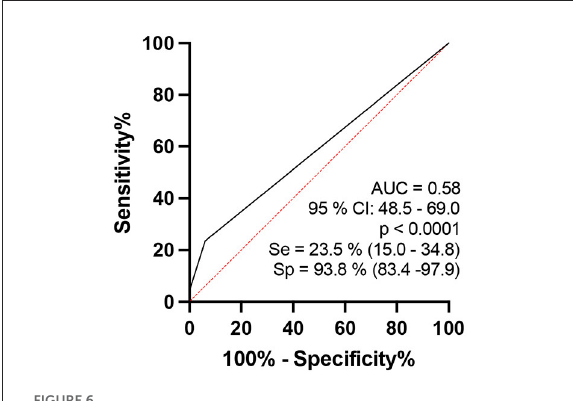
FIGURE6 ROC curve analysis of the percentage indices of the number of focalities ( 1 TpT) of the evaluated neural points considered to be altered per individual when comparing the groups of healthy persons and contacts of HD patients aged 15–60